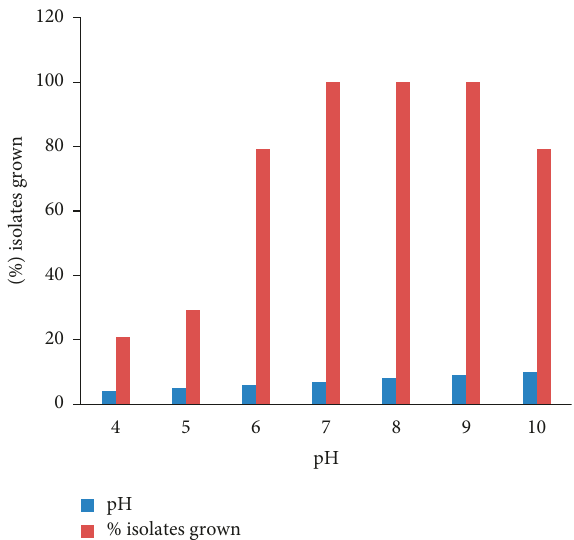
Figure 4: The growth of the rhizobial isolates at different temperature.